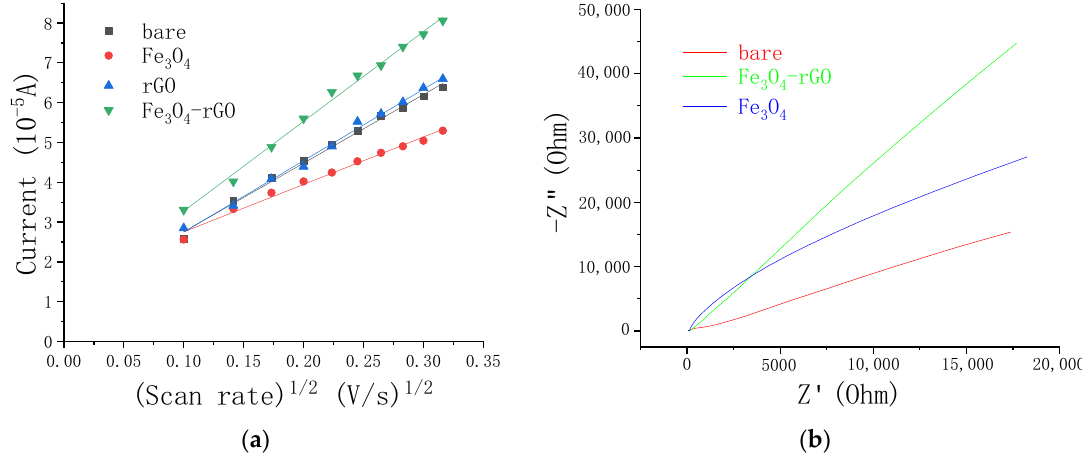
Figure 5. ( a ) linearity curve between the anodic peak current and the square root of the scan rate; ( b ) EIS plot of bare/GCE, Fe 3 O 4 /GCE , and Fe 3 O 4 –rGO/GCE.